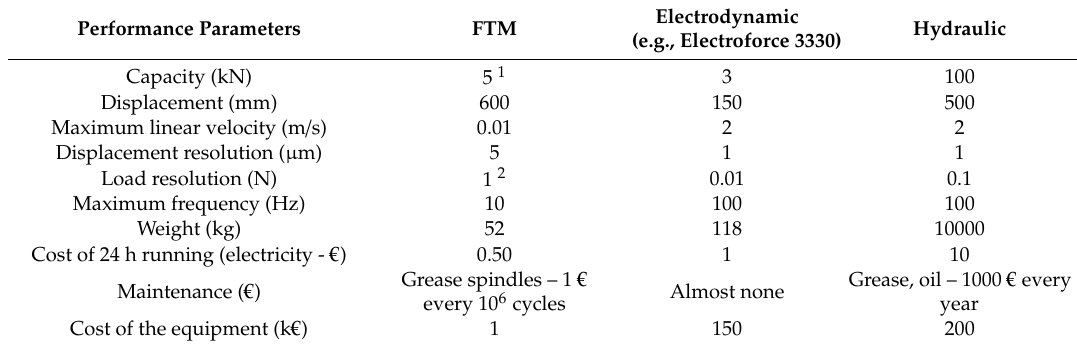
Table 1. Comparison of key performance parameters between the FTM and traditional machines.